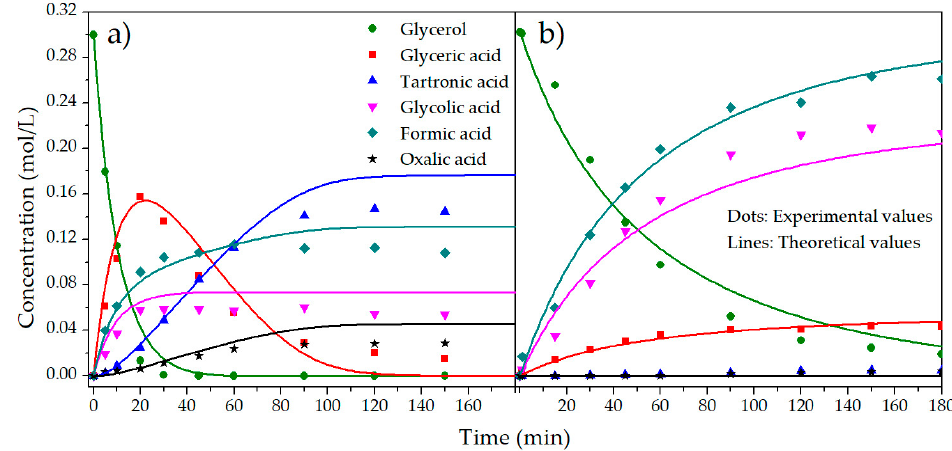
Figure 2. Experimental and calculated C/t-profile of the GLY oxidation with a supported Au catalyst ( a ) and without a catalyst ( b ). Reaction conditions: C 0GLY = 0.3 mol/L, pO 2 = 5 bar, T = 100 °C, GLY/Au = 3500 mol/mol (a) and ∞ (b), NaOH/GLY = 4 mol/mol, stirring speed = 1500 rpm.